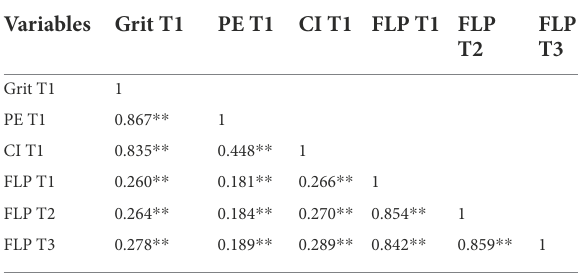
TABLE 4 Correlation among key variables.